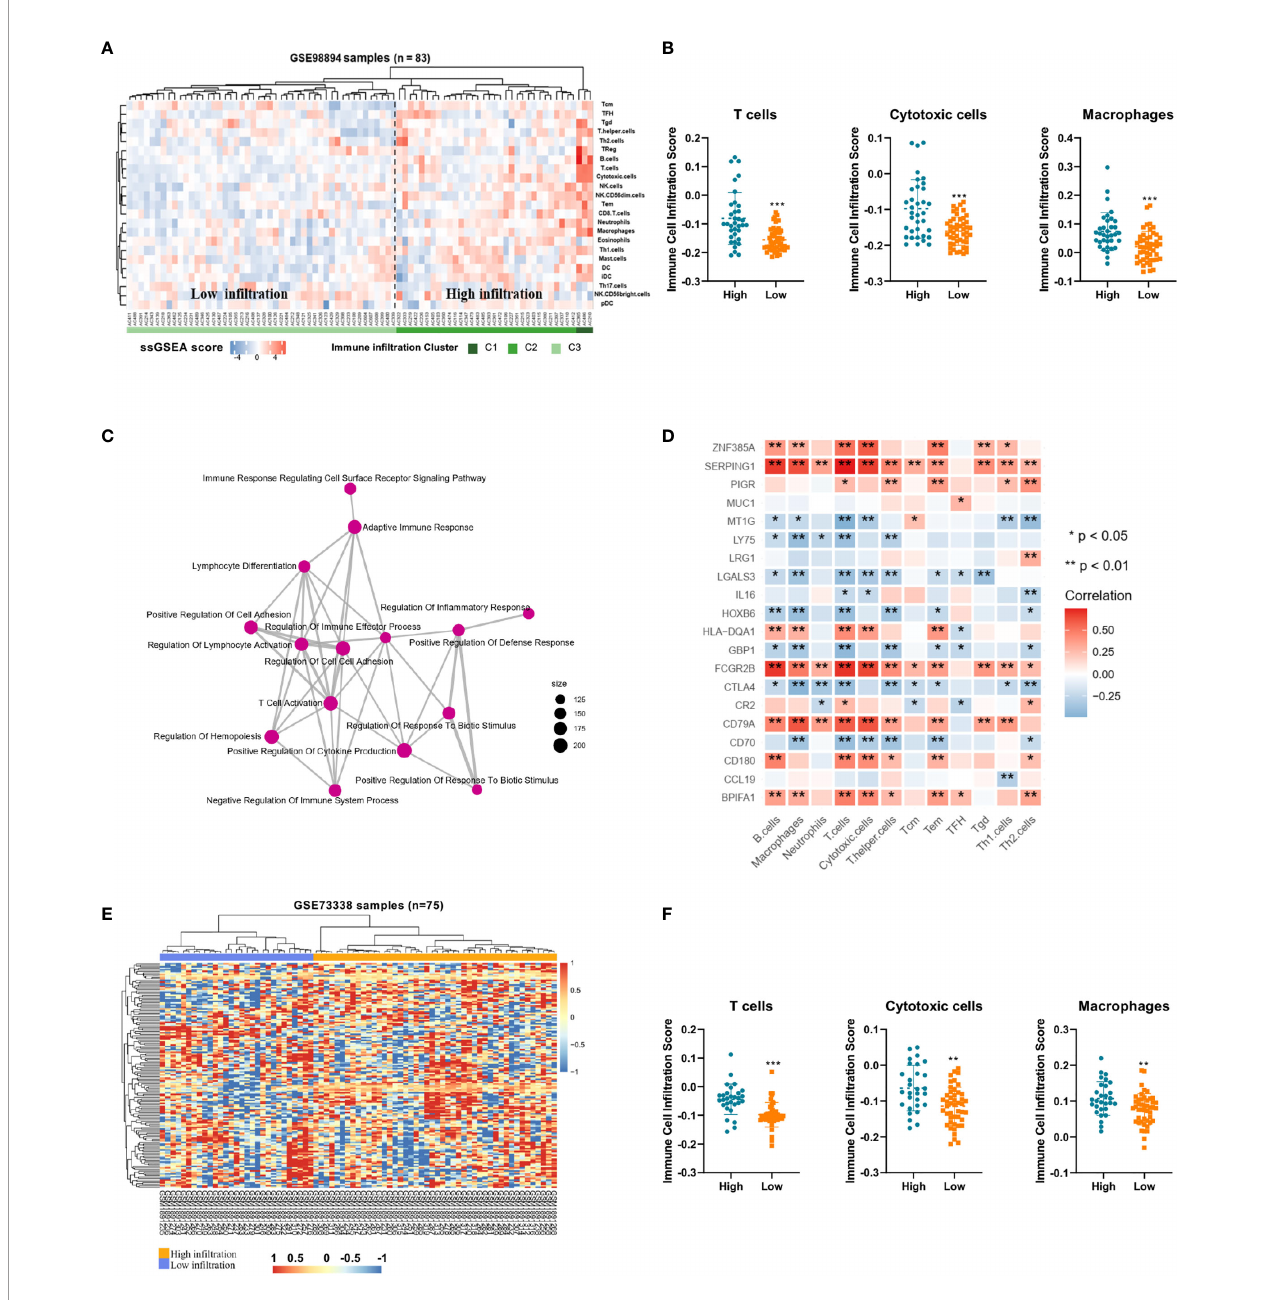
FIGURE 2 | Immune pro fi les and candidate immune signatures in Pan-NETs revealed by two GSE datasets (A) Heatmap for immune cell in fi ltration from the GSE98894 dataset. (B) Enriched T lymphocytes, cytotoxic cells and macrophages showed statistically signi fi cant differences between the high- (including high- and moderate-in fi ltration) and low-in fi ltration populations. (C) GSEA con fi rmed most of the biological processes of enriched immune signals. (D) The correlation of immune signature genes and immune cell types is shown. Red boxes indicate a positive correlation; blue boxes indicate a negative correlation. (E) Heatmap for clustering of the GSE73338 dataset with 150 immune signatures resulting in two subgroups with similar immune cell in fi ltration differences. (F) Enriched immune cell types were signi fi cantly different in the GSE73338 population. (*indicates 0.05, **indicates 0.01, ***indicates